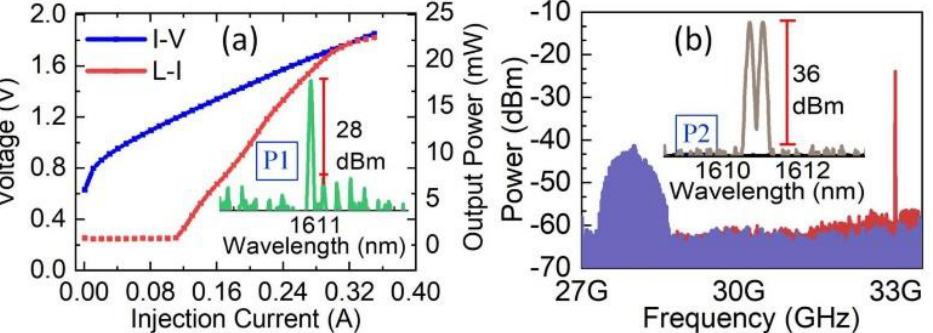
Figure 1. Experimental setup with a self-injection-locked (SIL) quantum-dash dual-wavelength laser diode (QD-DWL) for the generation of a 33-GHz millimeter-wave (MMW) carrier beat tone. The glossary of terms utilized is summarized in the Glossary.